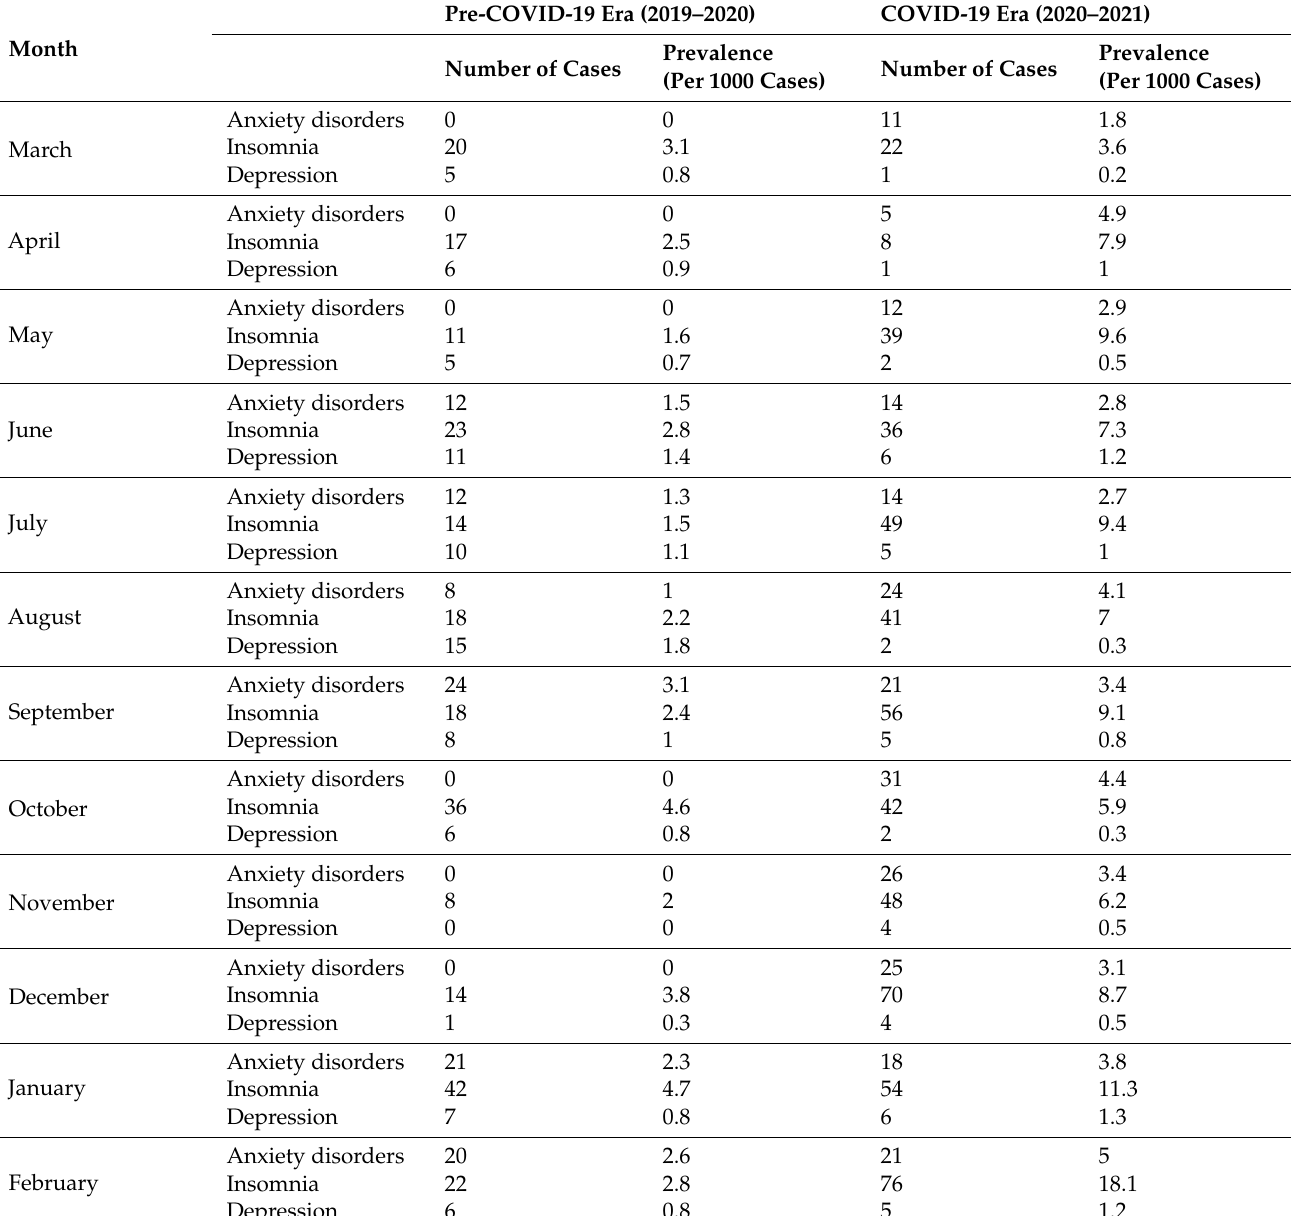
Table 2. Cases of anxiety disorders, insomnia, and depression in the pre-COVID-19 and COVID-19